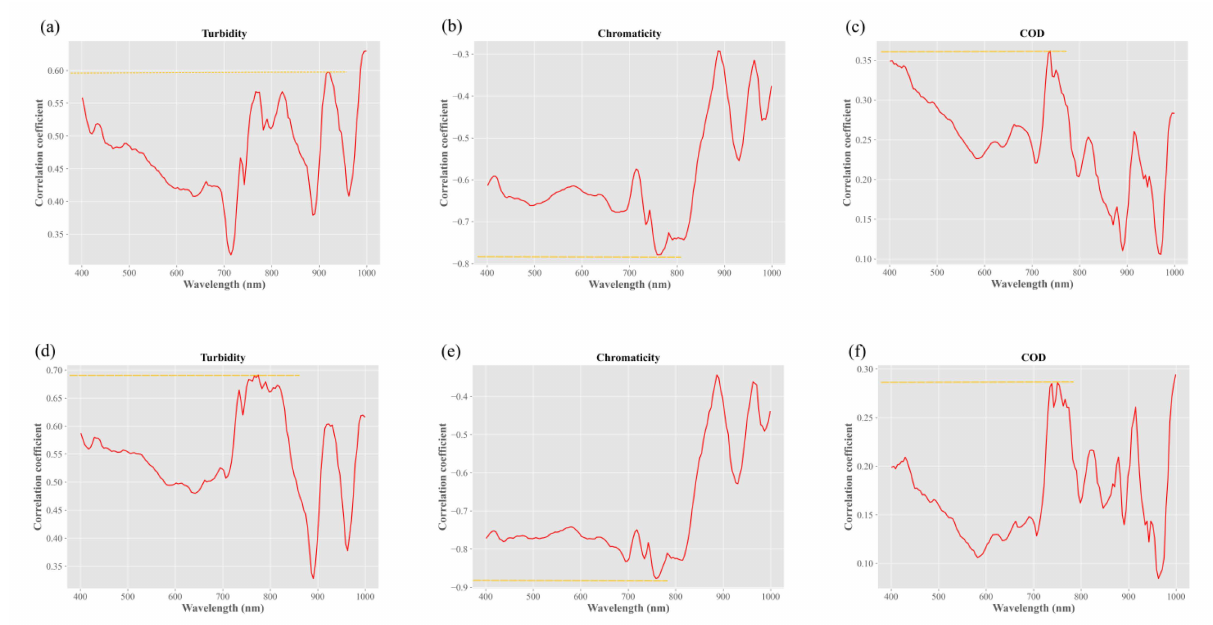
Figure 4. The band correlation curves of the water quality parameters (Turbidity, Chromaticity, COD). ( a – c ) are original band correlation curves of the water quality parameters. ( d – f ) are band correlation curves after the process of noisy instance selection.